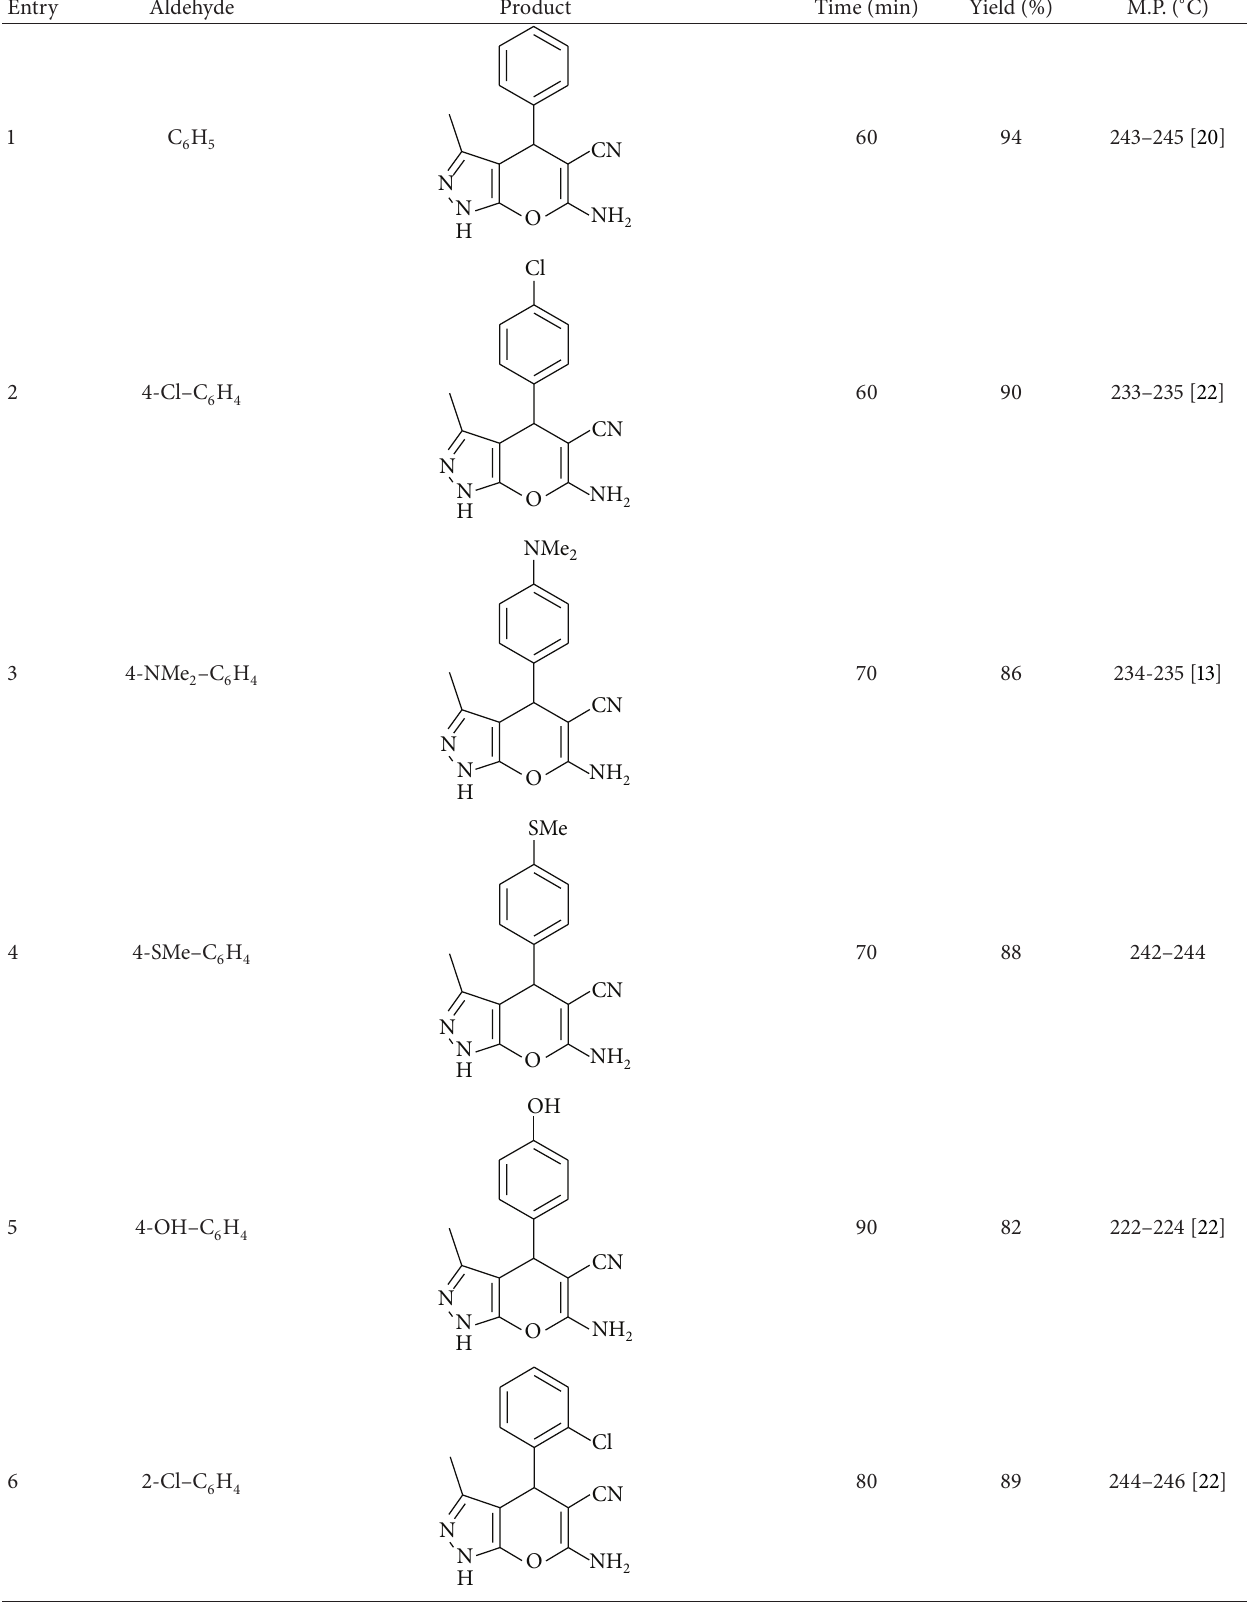
Table 1: ZnO nanoparticle catalyzed one-pot four-component synthesis of pyranopyrazoles in aqueous